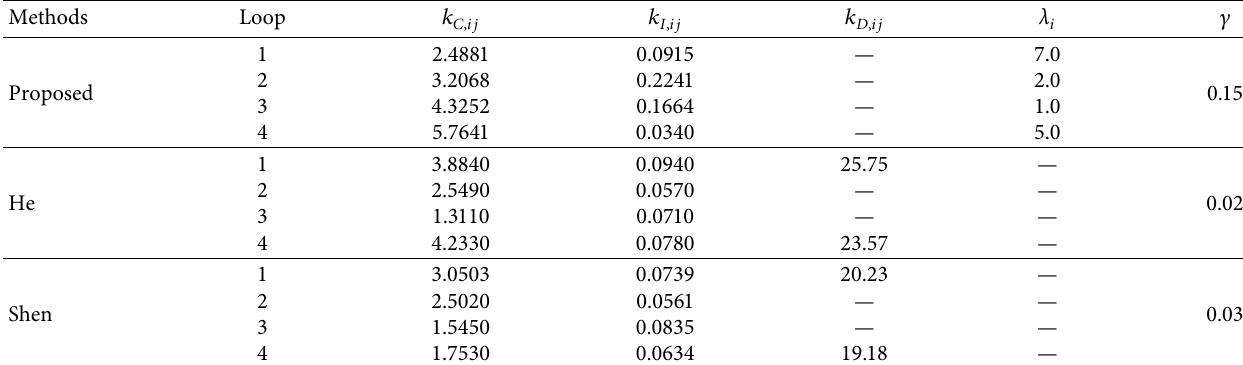
Table 5: Controller